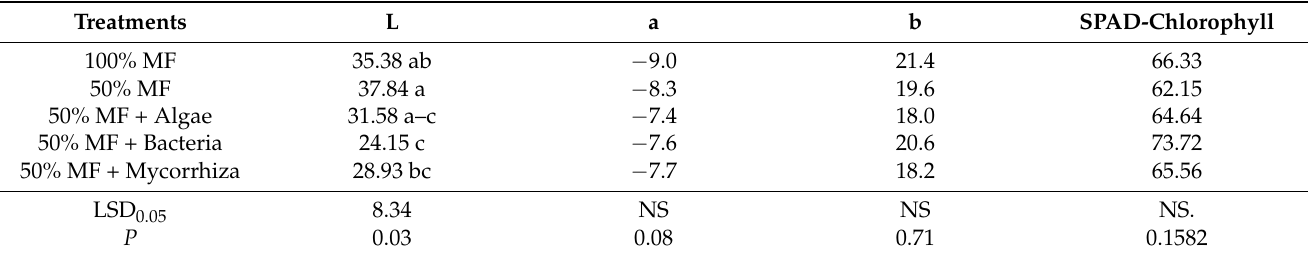
Table 4. Effects of the biofertilizers on baby spinach leave color’s